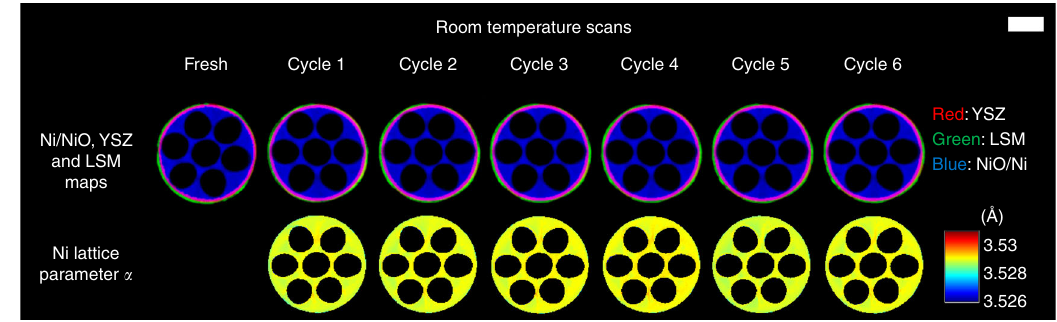
Fig. 5 X-ray diffraction computed tomography of fuel cell during the thermal cycling. Row 1: Red green blue (RGB) images showing the distribution of the main SOFC components during the thermal cycling test (red: YSZ, green: LSM and blue: NiO/Ni). Row 2: the Ni unit cell lattice parameter a maps during the thermal cycling test as derived from the Rietveld analysis of the corresponding XRD-CT data. The scale bar corresponds to 0.5